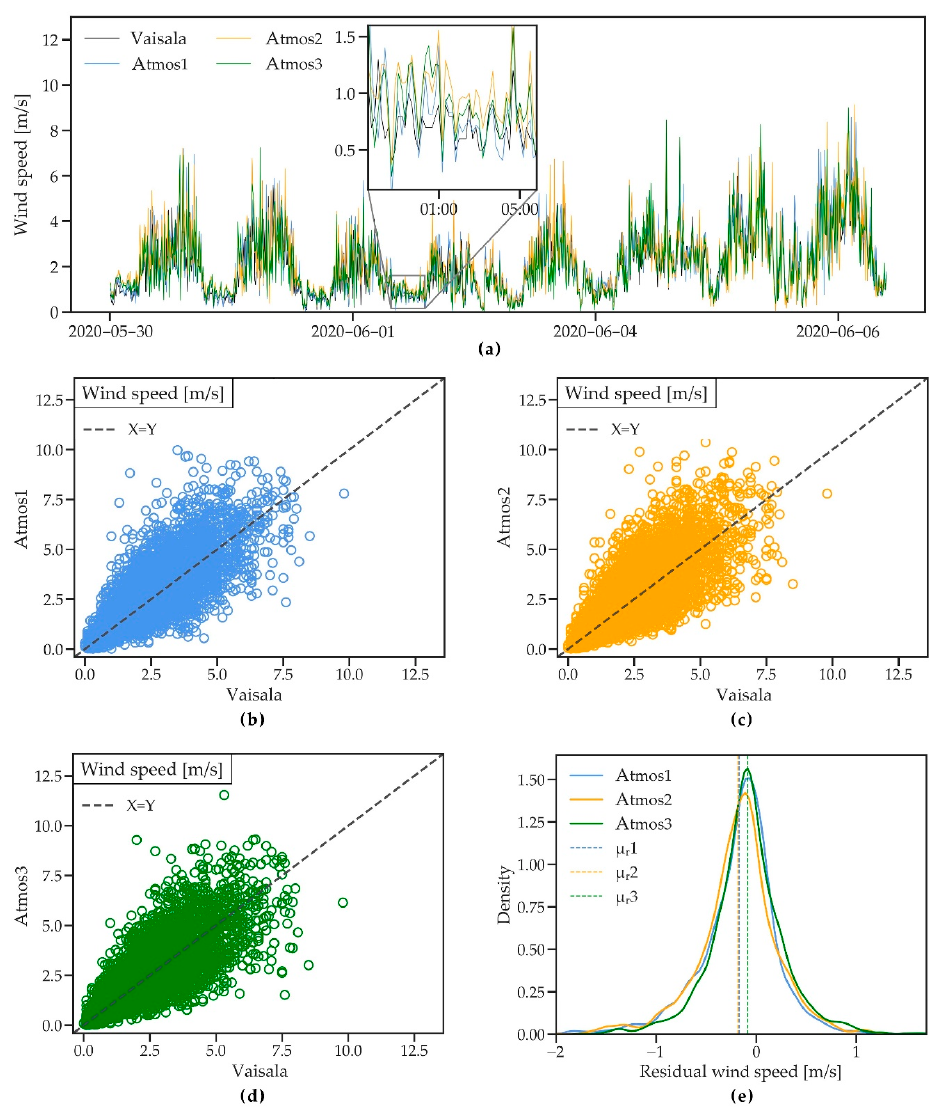
Figure 9. ( a ) A short time series of wind speed measured by three ATMOS41 weather stations and the ICOS-bkp station from 30 May to 6 June 2020. ( b – d ) Scatterplots of 10 min wind speed for the three ATMOS41 stations vs. the reference station. ( e ) Probability density functions of the residual mean hourly wind speed. Dashed lines show the mean of residuals ( μ r ).